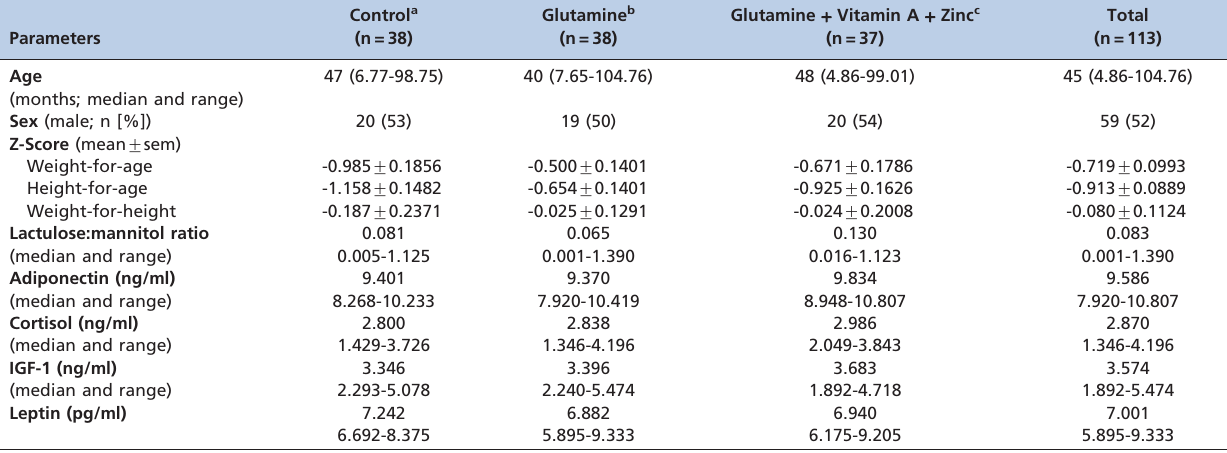
Table 1 - Characteristics of children at baseline, including age, sex, anthropometric indices, intestinal permeability, and treatment